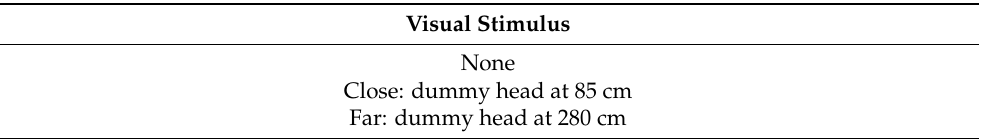
Table 2. The levels of the visual stimulus (none present, dummy head close to the reader, dummy head far from the reader) as the only factor investigated in the reading part of the experiment, yielding three different experimental conditions the subjects experienced during reading.